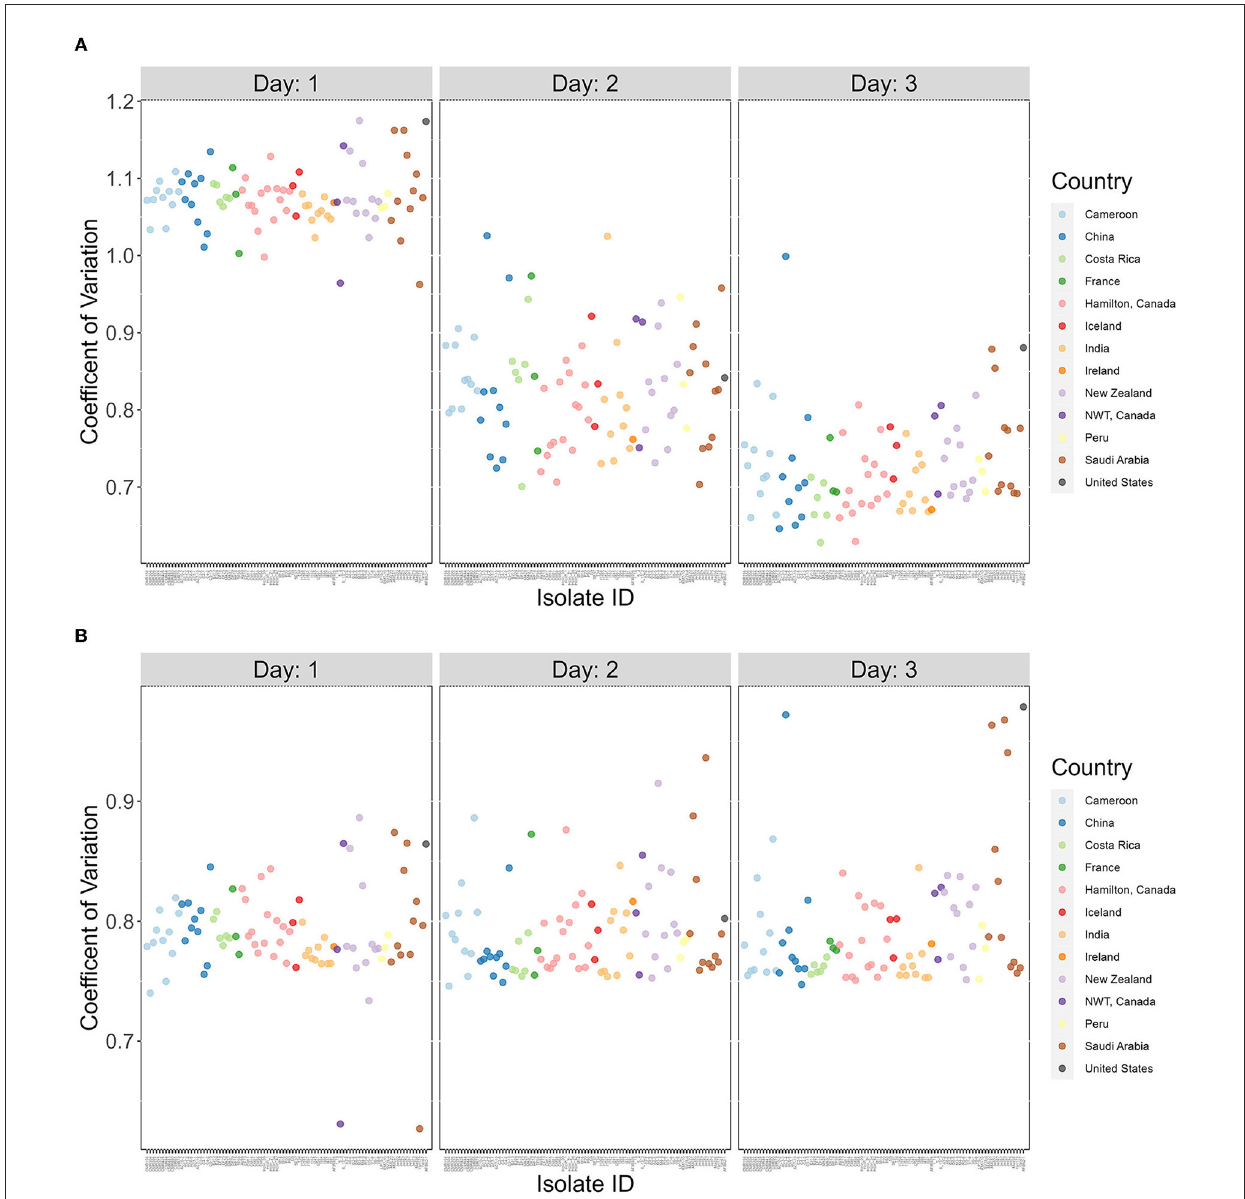
FIGURE5 The coefficients of variation are highly variable among A. fumigatus strains but decreased over time. X-axis represents 89 A. fumigatus . Y-axis represents coefficient of variation (CV) values for each strain. (A) CV calculated based on all four temperatures (15 ◦ C, 22 ◦ C, 35 ◦ C, and 41 ◦ C). (B) CV calculated based on three temperatures (15 ◦ C, 35 ◦ C, and 41 ◦